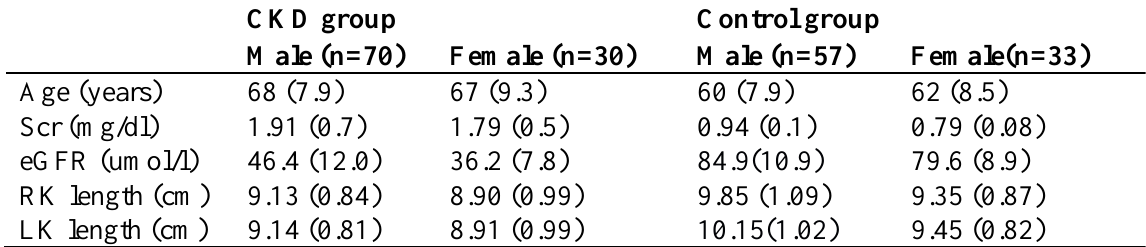
Table 01: Comparison of biochemical and renal ultrasound parameters of the study